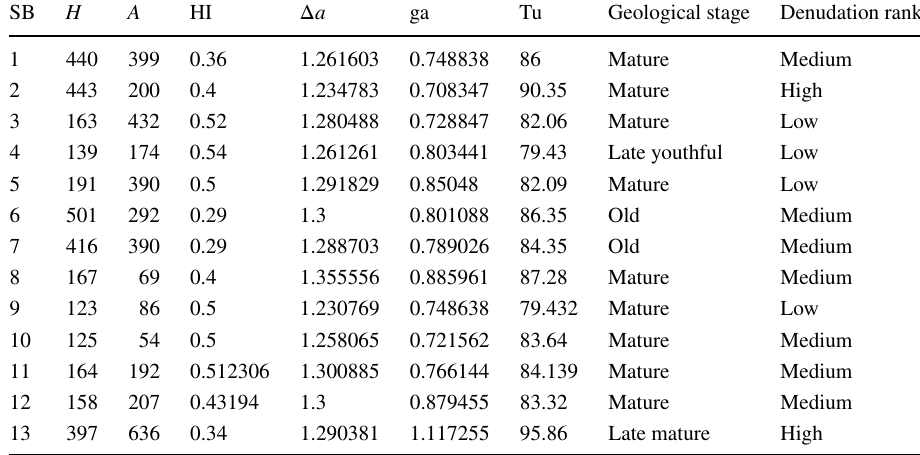
erosion susceptibility in study